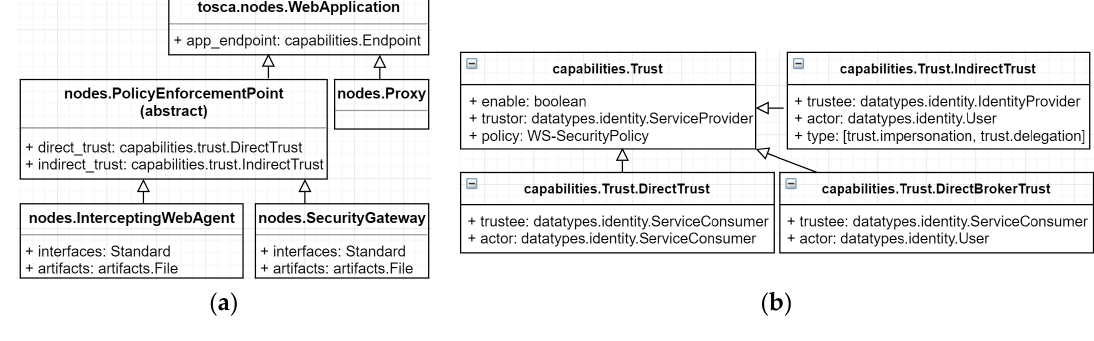
Figure 5. ( a ) Node types; ( b ) Capabilities